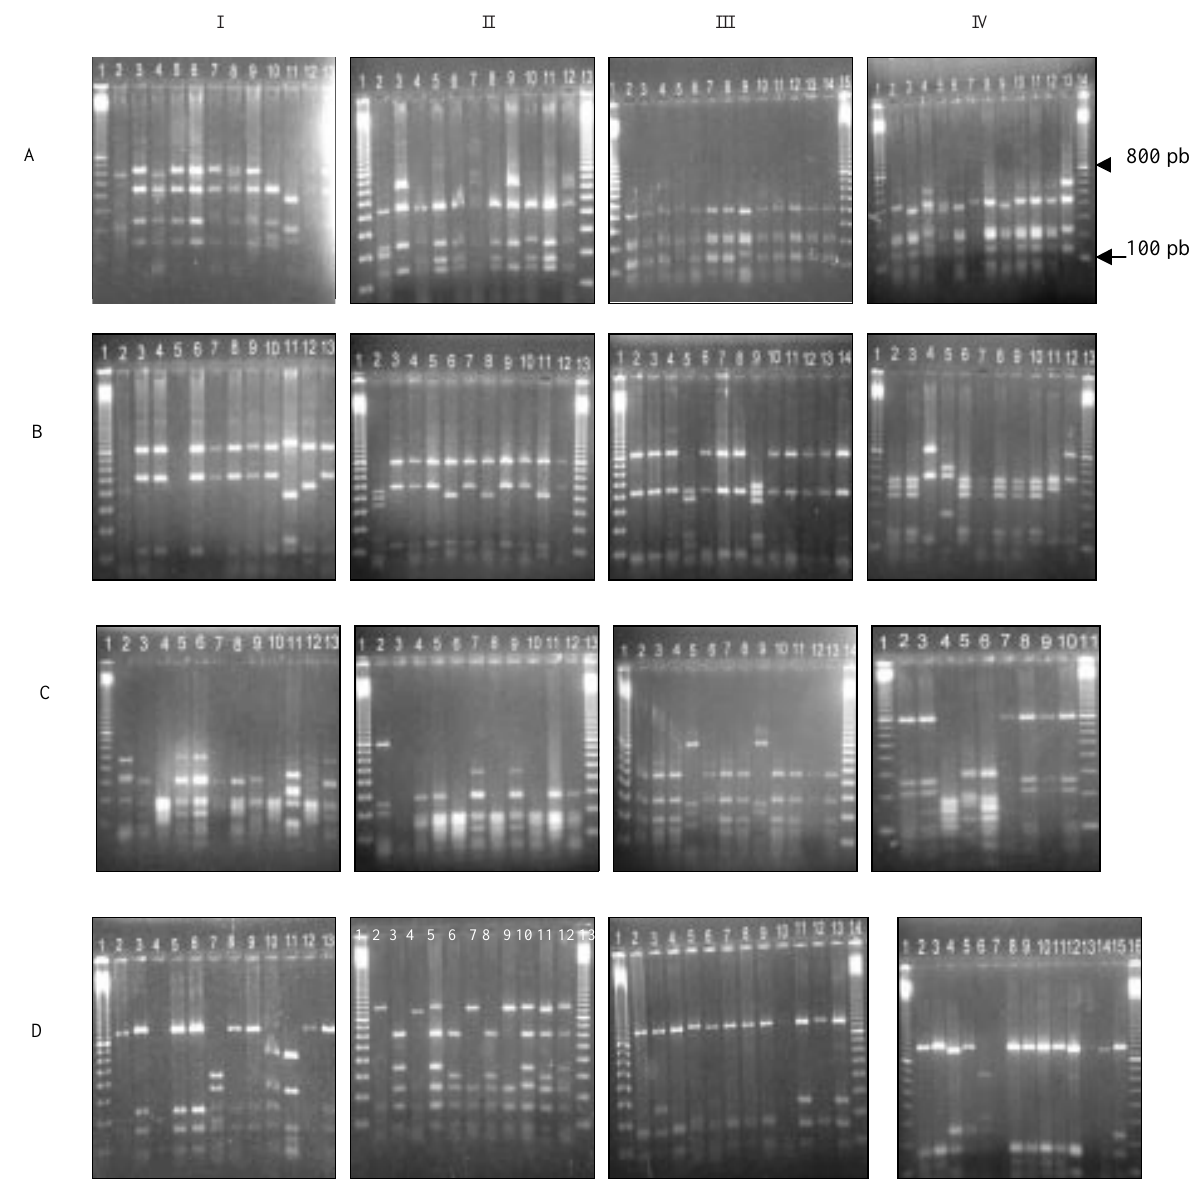
Figura 2. Perfis de Restrição dos fragmentos da região 16S DNAr dos isolados bacterianos gerados pelas enzimas Alu I (A) , Rsa I (B) , Hae III (C) e Mbo I (D). (I) Restrição dos isolados bacterianos caracterizados fenotipicamente como A. brasilense : linha 1 marcador 100 bp ladder, Gibco BRL, Linha 2 -estirpe Sp7, linhas 3 a 13 – isolados 65Ab, 69Ab, 60Ab, 67Ab, 20Ab, 41Ab, 37Ab, 36Ab, 15Ab,